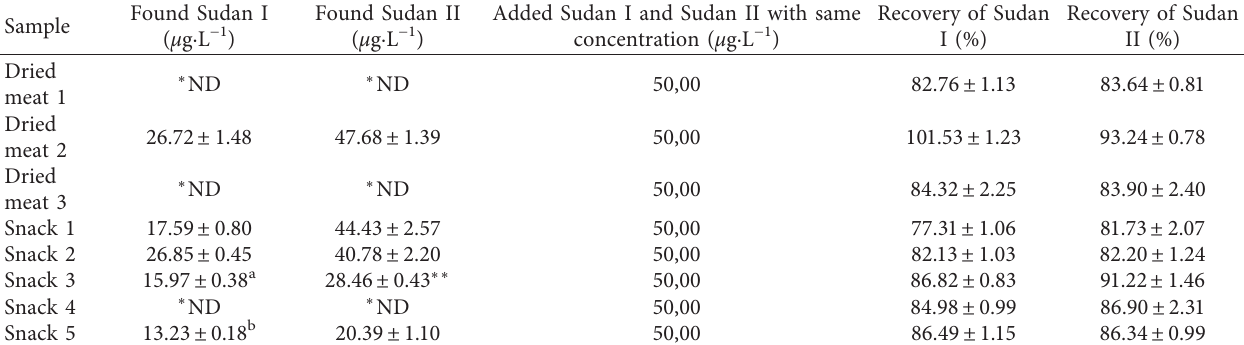
Table 3: Quantification of Sudan I and II in food samples (mean ± confidence, n � 3). Sample